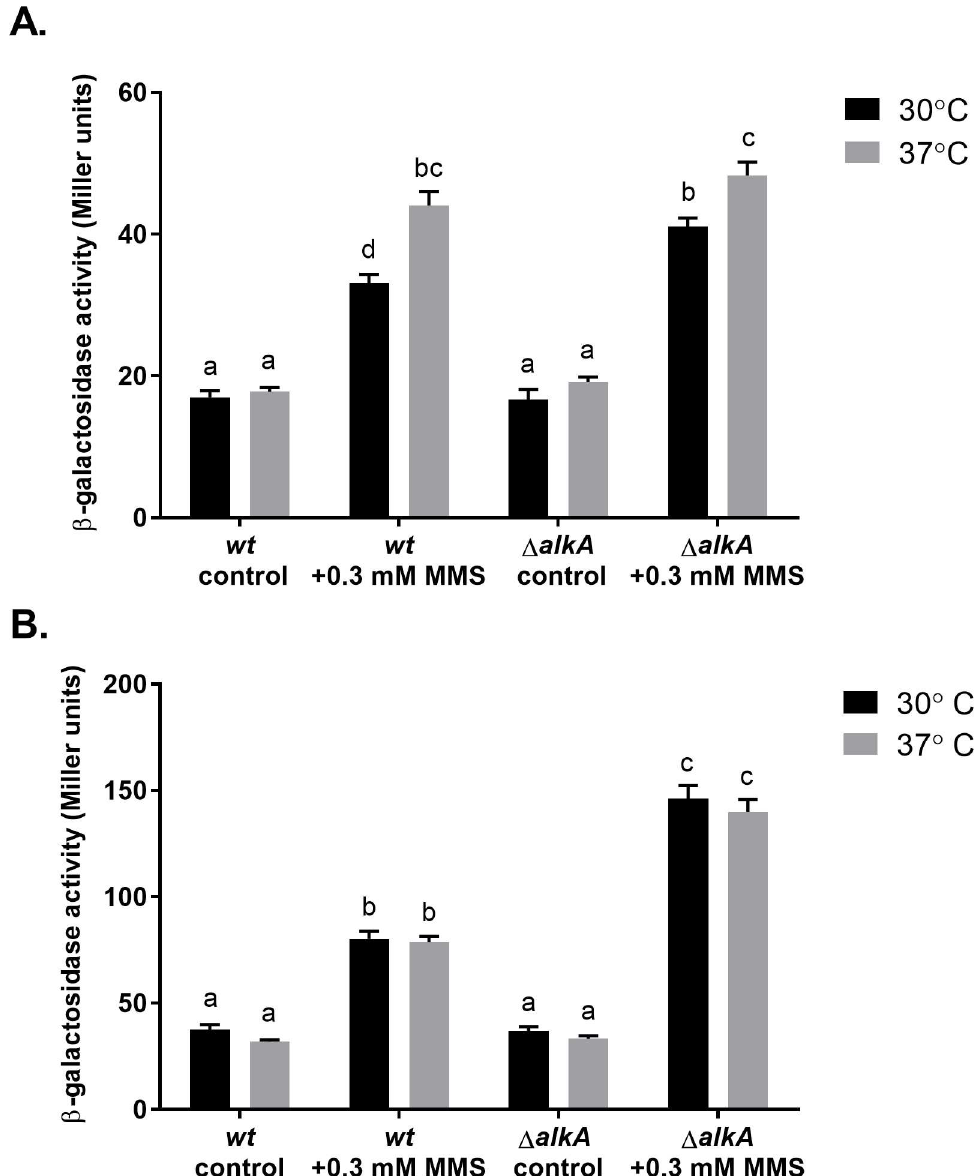
Fig 13. Effect of incubation temperature on transcription from the P . putida lexA2 promoter. β - galactosidase activities expressed from the lexA2 promoter- lacZ reporter were measured in the P . putida wild-type and in its alkA- deficient derivative incubated at 30˚C (black) or 37˚C (grey) for 1 hour (A) and overnight (B) in liquid LB medium supplemented with 0.3 mM MMS or not (control). Data represents the mean ( ± SE) values. Letters indicate homogeneous groups according to ANOVA followed by Bonferroni’s multiple comparisons test ( P < 0.01).